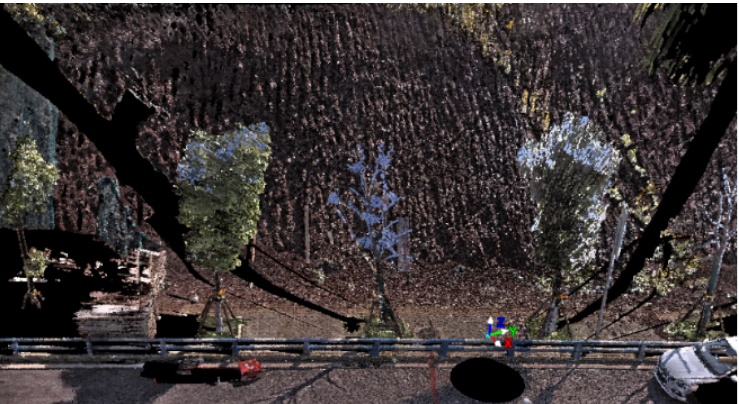
Figure 13. Lihua landslide point cloud of phase 1.